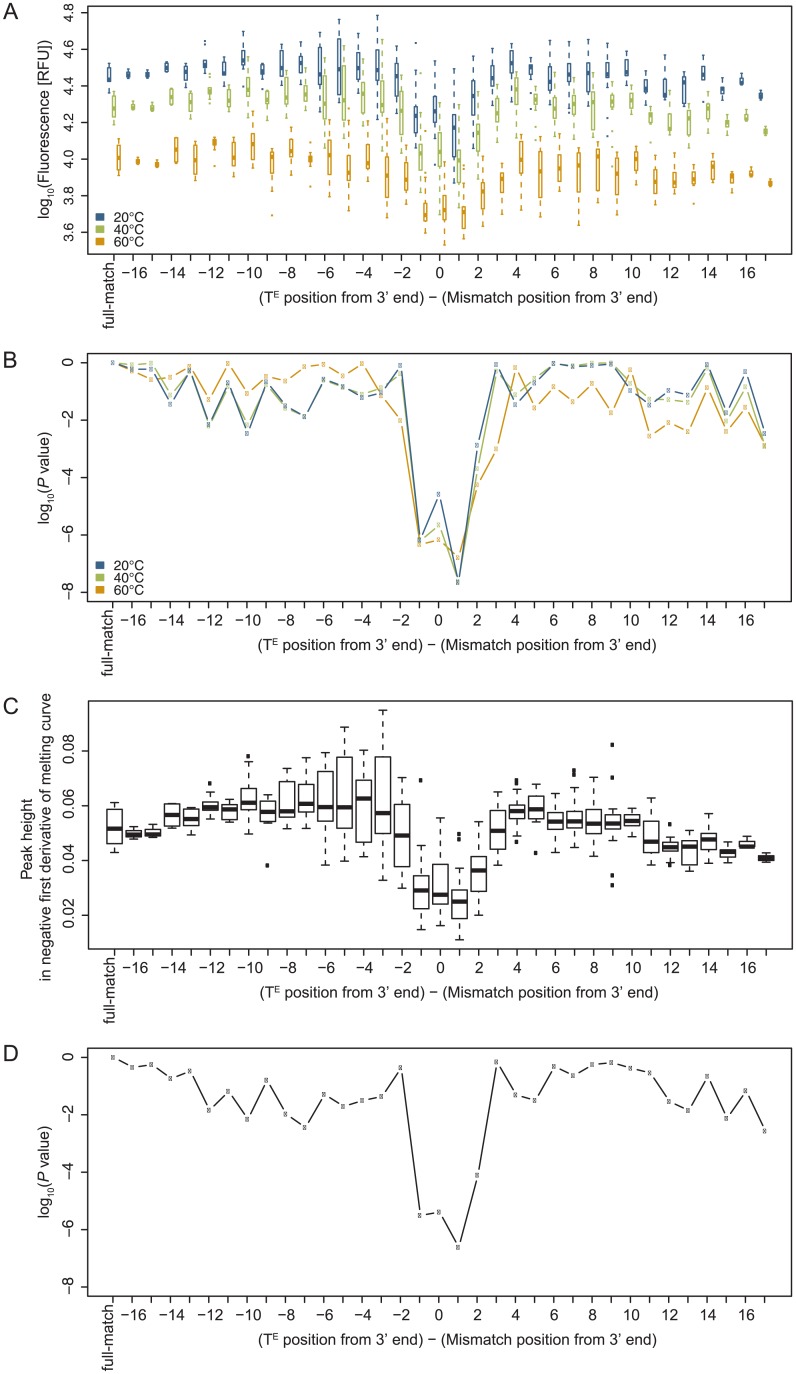
Effect of mismatched base pair positions relative to the thiazole-orange labelled nucleotide on (A) fluorescence intensity (at 20, 40 and 60°C) and its P value (B) by comparison to full-match ECHO/DNA hybrids (Student’s T test, two-tailed), and (C) peak height in negative first derivative of melting curves and its P value (D) by comparison to full-match ECHO/DNA hybrids (Student’s T test, two-tailed).Each boxplot and point in (A-D) summarizes ECHO/DNA pairs with different ECHOs having the same distance from the labelled nucleotide to a mismatch, using mean values among replicates of each ECHO/DNA pair.